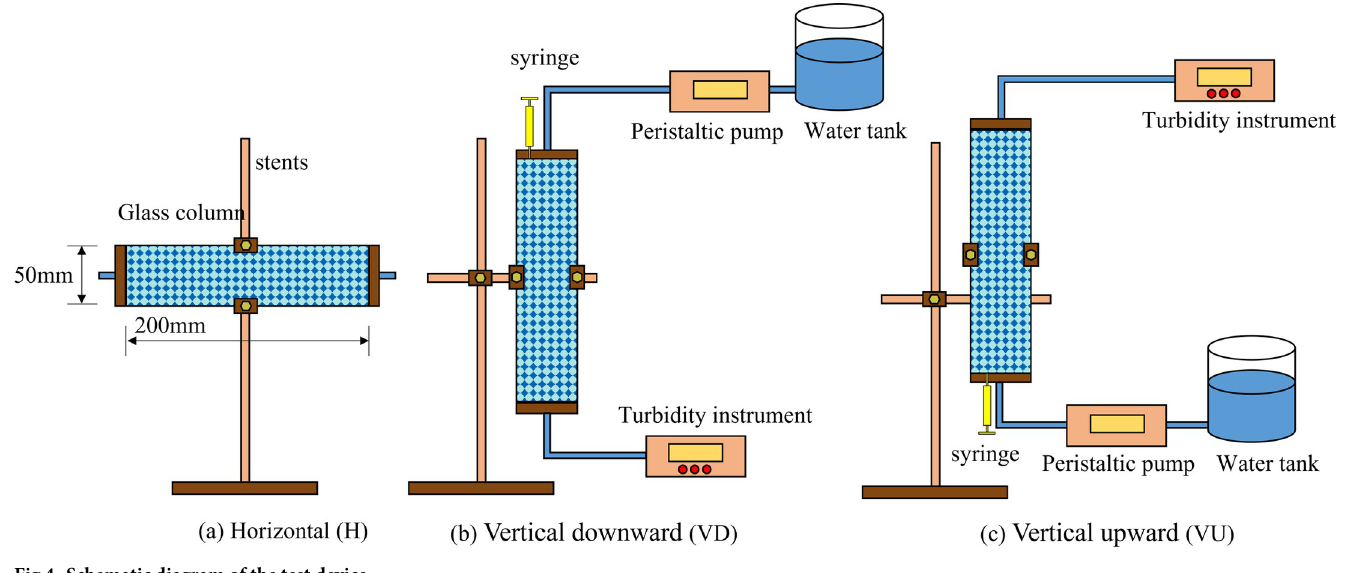
Fig 4. Schematic diagram of the test device.